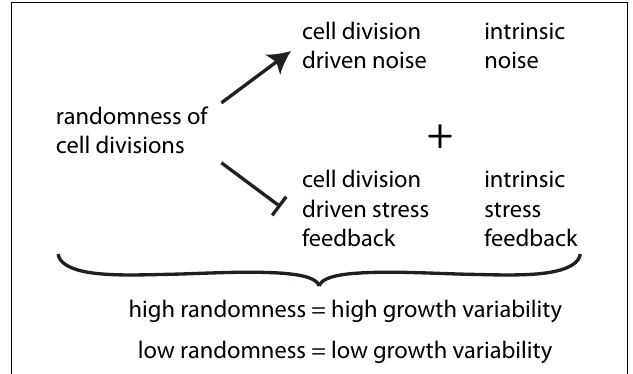
FIGURE 6 | Synopsis of the effect of cell divisions on growth variability. The degree of randomness of cell divisions induces noise in addition to intrinsic noise in individual growth rates of cells.Thereby it reduces the effect of stress feedback arising from both cell division driven and intrinsic stress feedback. High randomness of cell division thus leads to high tissue growth variability while tissue reinforcement in the direction of maximal stress, and thus contributes to stress feedback in addition to intrinsic feedback, which decreases growth